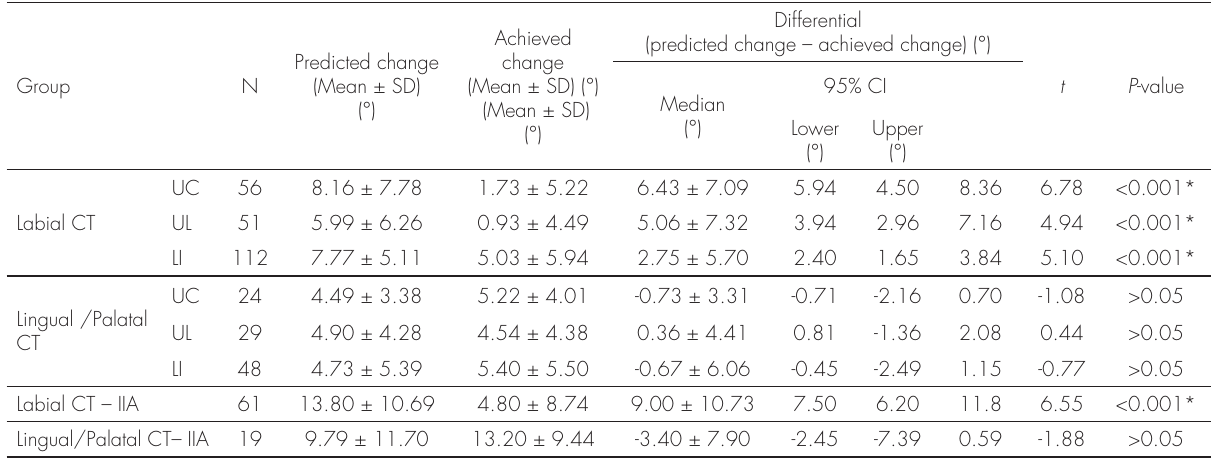
Table III. Descriptive statistics and paired student t -test values for torque, IIA differential.